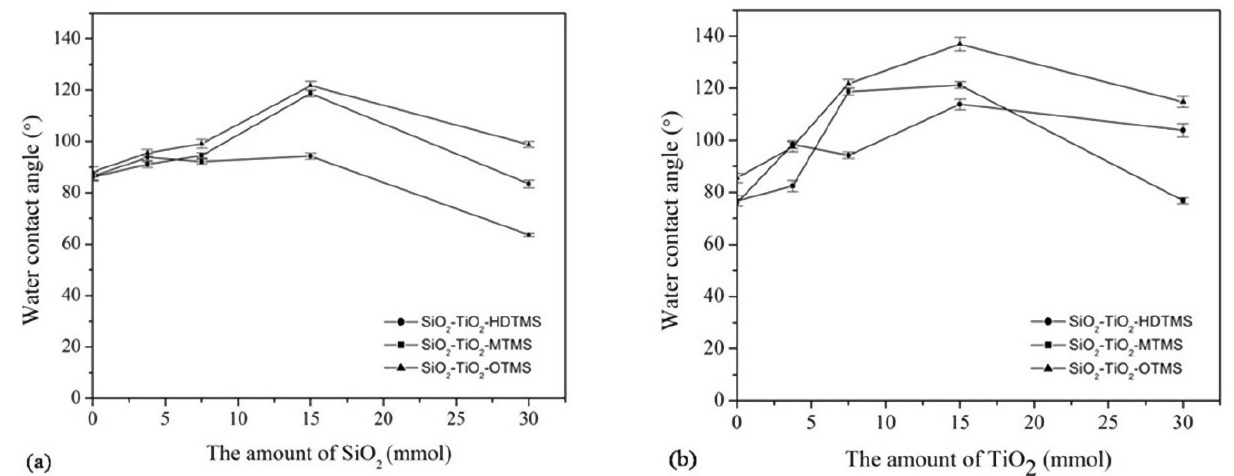
Figure 2. Water contact angle of SiO 2 -TiO 2 -alkylsilane coatings prepared with various compositions of ( a ) SiO 2 (x mmol SiO 2 , 7.5 mmol TiO 2 , and 15 mmol alkylsilane) and ( b ) TiO 2 (15 mmol SiO 2 , x mmol TiO 2 , and 15 mmol alkylsilane).